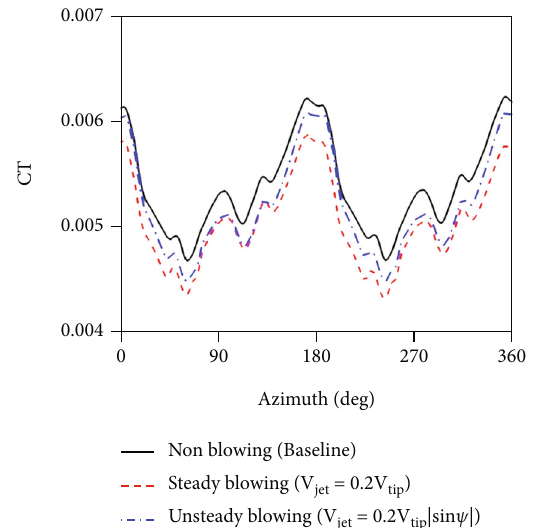
Figure 10: Rotor thrust coe ffi cients with azimuthal angles for the steady/unsteady blowing